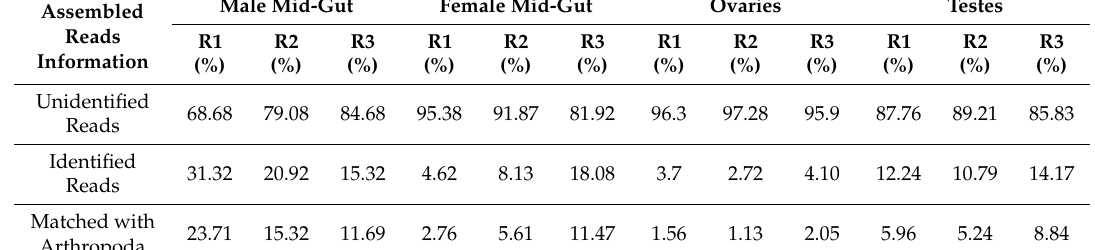
Table 2. Assembly metrics for two-spotted field crickets transcriptome sequencing.